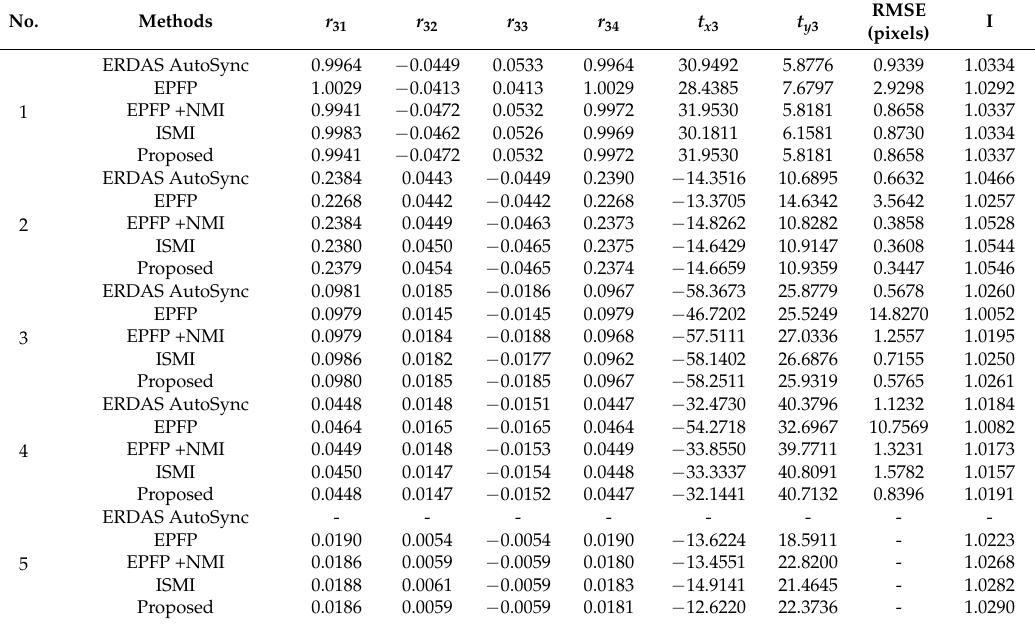
Table 3. Experimental results of different registration methods. EPFP: edge point features-based preregistration method; NMI: normalized mutual information-based registration method; ISMI: improved SMI-based